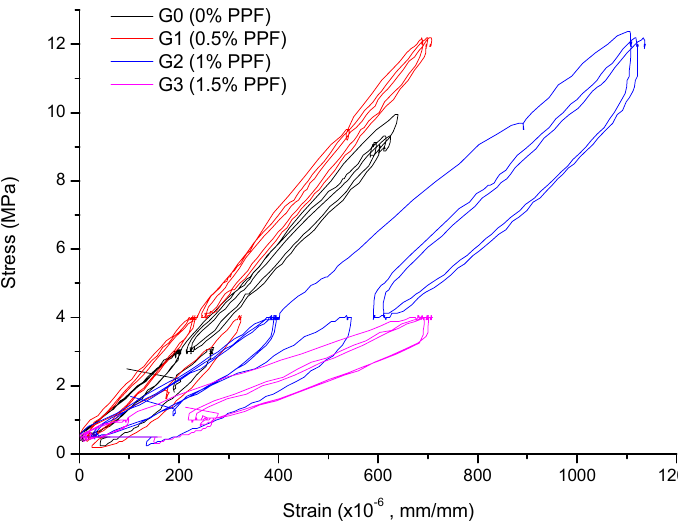
Figure 6. Stress–strain curves in the elastic range at 14 days .